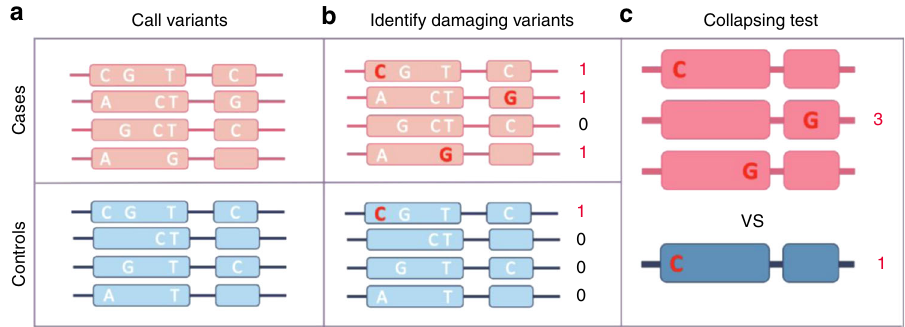
Fig. 1 Gene-based collapsing analysis. a First, variants in each gene are identi fi ed by sequencing. b Variants that are predicted to be damaging — those that are rare and annotated as likely to affect the functionality of the gene, such as coding variants — are then selected for analysis. c Finally, the number of cases with a qualifying variant in each gene is compared with the number of controls with a qualifying variant, producing one statistical result per gene instead of one per variant.